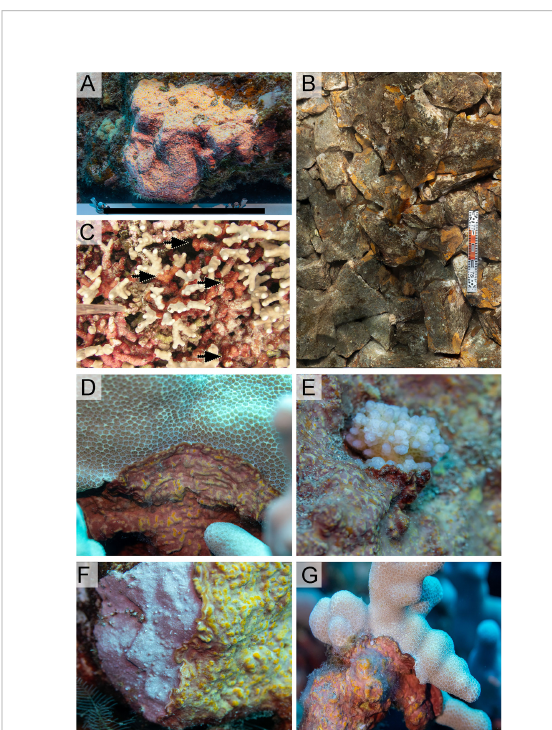
FIGURE 3 In-situ images of the morphology of Ramicrusta hawaiiensis overgrowing a basalt boulder on South Kona coral reefs in 2021. (A) Note the distinct color shift on the specimen with the upper lighter orange section and the lower red ventral section of the specimen, black line bar = 23 cm. Field observations have noted that surface-facing sections of this alga tend to be rusted orange while shaded sections of specimens have rusted red or pink hues. (B) Image from SfM orthomosaic where Ramicrusta hawaiiensis is prominent with orange encrusting morphology on basalt slabs, scale bar = 50 cm. (C) Field observations from 2003 DAR-WHAP photo-quadrat image surveys with Ramicrusta specimens noted by the black arrow. Images (D – G) show active overgrowth by Ramicrusta hawaiiensis on (D) Porites lobata , E. Pocillopora spp., (F) Crustose Coralline Algae (CCA), and (G) Porites compressa .